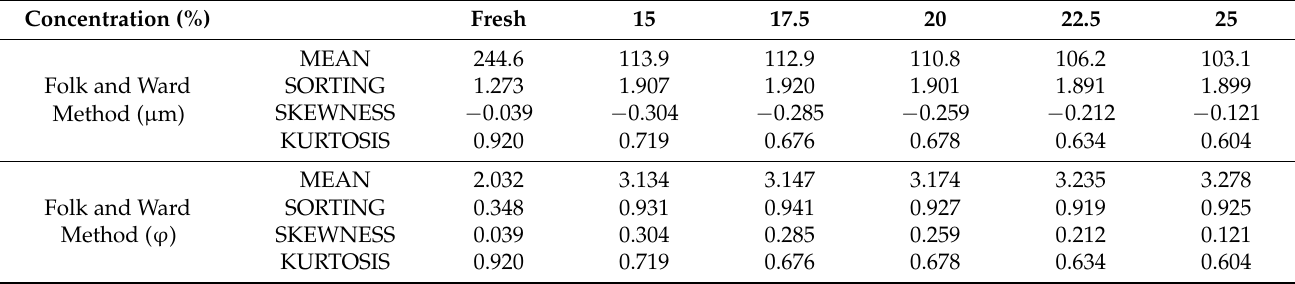
Table 4. Alluvial garnet grains distribution